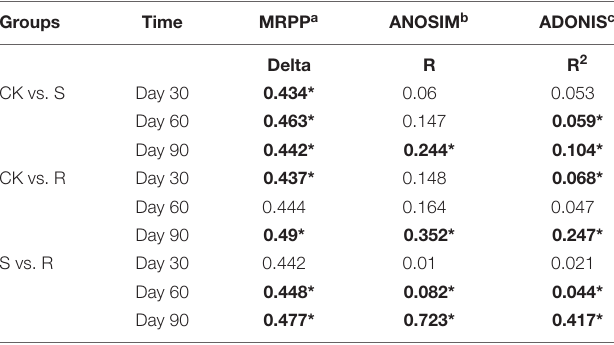
TABLE 1 | Dissimilarity tests of bacterial community structure among treatments with different microflorae enriched from soil (S), root (R), and treatment with ddH 2 O (CK).